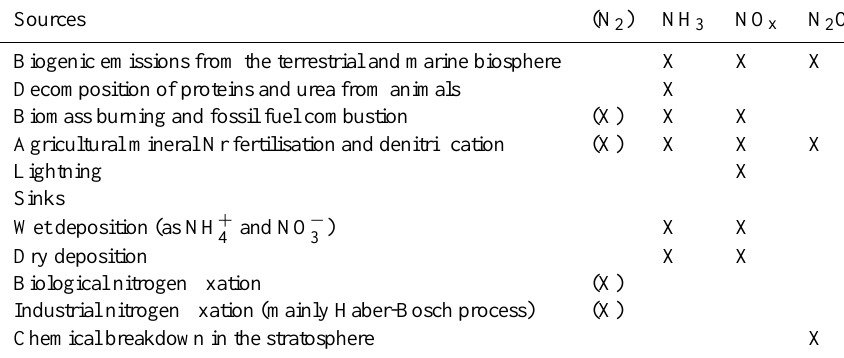
Table 1. Overview of the main sources and sinks of atmospheric nitrogen-containing species. N 2 has been listed for completeness, but is not discussed further, as the paper focuses on reactive N species only.